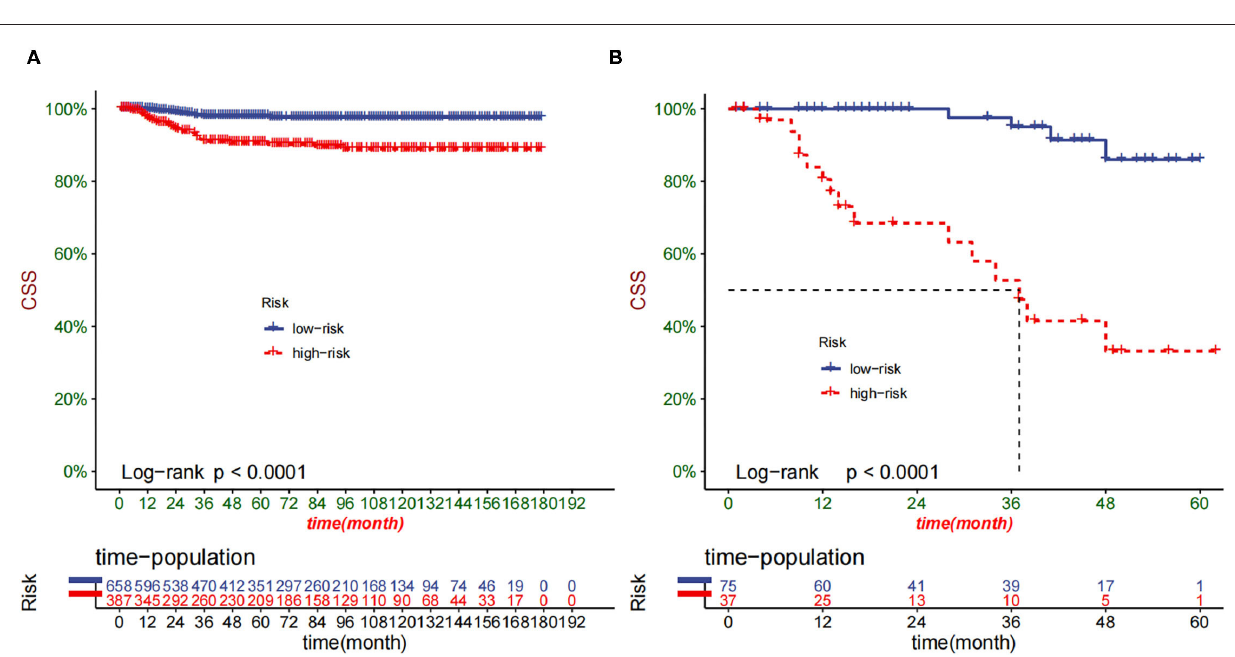
FIGURE 9 | Kaplan–Meier curves of CSS for children in the low- and high-risk groups in SEER (A) and CHCMU cohort (B)